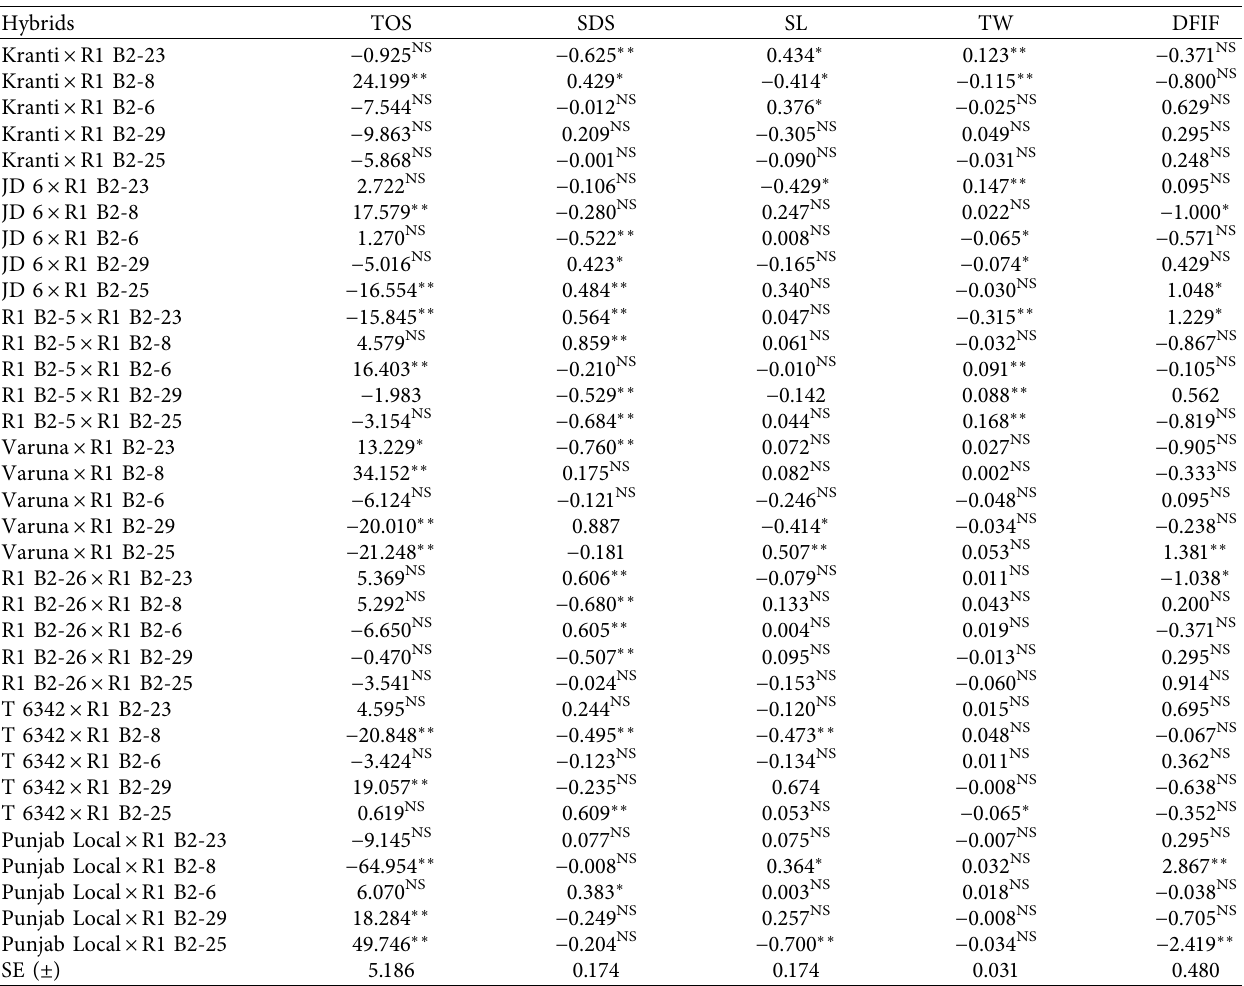
Table 9: Specific combining ability (SCA) effects of mustard hybrids on yield and its attributed